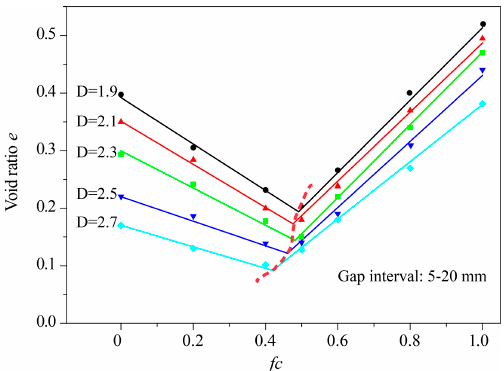
Figure 8. Changes of void ratios of the SRMs with f c under different basic gradations.